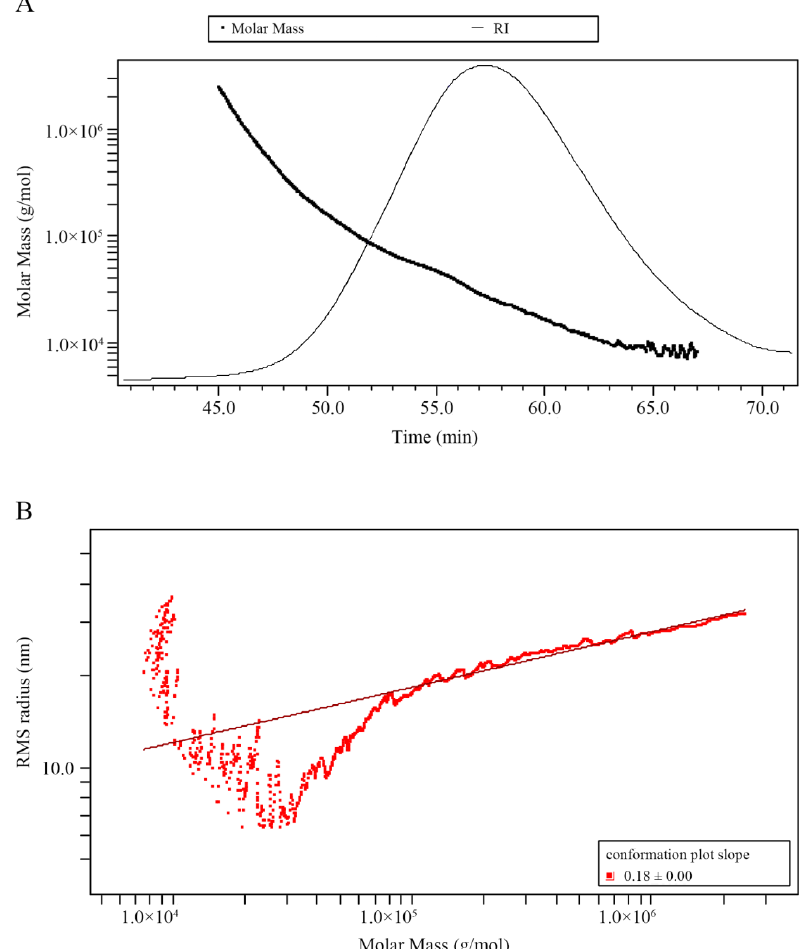
Figure 3. Plots of molecular weight distribution ( A ) and molecular conformation ( B ) of GP2a. ( A ) Superimposed chromatograms of GP2a obtained by size exclusion chromatography connected with multi-angle laser light scattering and refractive index (RI) detectors; the RI trace shows the signals collected by the RI detector; the molar mass trace was fitted by laser light scattering signals and RI signals, indicating molecular weight distribution. ( B ) Log–log plot of r g versus Mw; RMS—root mean